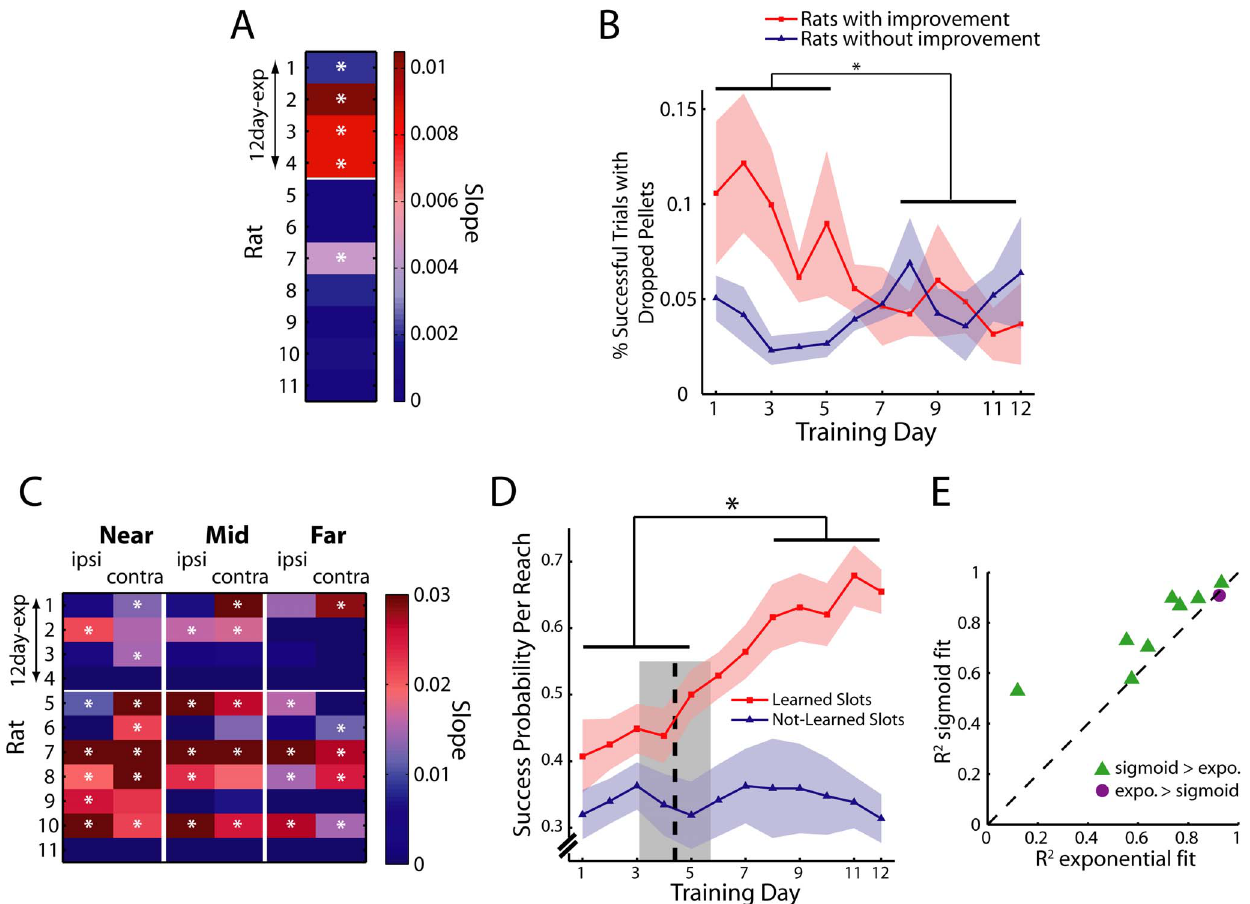
Figure 2. Improvement in task goal achievement exhibited a sigmoid time course. A, Eleven rats (rats 1–4 in 12-day-Reach group) were trained for 12 days to reach and grasp pellets from six different locations in the workspace, including slots ipsilateral (ipsi) and contralateral (contra) to the rat’s preferred side, at the Near, Mid, and Far levels (Fig. 1A), respectively. The first measure of motor learning we used indicates the quality of reaching by quantifying the percentage of successful trials in which the pellet was dropped either to the inside of the slit or to the box’s floor. Different rats showed different rates of improvement (blue, low rate of decrease; red, high rate) with 5 of the 11 rats showing a statistically significant decrease (*, Pearson’s correlation coefficient , 0, p , 0.05). The top four rows correspond to data from rats included in the microarray analysis. B, For the 5 rats showing across-day improvement in movement quality, there was a clear decrease in the percentage of successful trials with dropped pellets over time (red, mean 6 SE). The percentage values of the first five days were greater than those of the last five days for these rats (*, p , 0.05, ANOVA) but not for the other rats (blue). C, As a second measure of skill learning, we quantified the degree of task goal achievement across days. We examined whether there was across-day increase in the probability of successful retrieval per reach for each individual slot by linearly regressing the learning curve for each slot against time. Different rats exhibited performance improvement at different rates at different slots (blue, low improvement rate; red, high improvement rate) with different subsets of slots showing a significant increase in the success probability (*, Pearson’s correlation coefficient . 0, p , 0.05; ‘‘Learned’’ slot). The top four rows correspond to data from rats included in the microarray analysis. D, The probability of successful retrieval per reach was calculated over the slots showing significant improvement (Learned Slots; red, mean 6 SE) and the other remaining slots showing no improvement (Not-Learned Slots; blue), respectively. The learning curve for the Learned Slots exhibited a sigmoid time course with the success probability starting to increase at Day 4.4 6 1.3 (t 10%-max , black dotted line; mean 6 SE). For the Learned Slots, the probability values of the first 5 days were also significantly lower than those of the last 5 days (*, p , 0.05, ANOVA). E, The learning curve from the Learned Slots of every rat was regressed onto a sigmoid and an exponential function, respectively. When the regression R 2 values of the sigmoid fit were plotted against those of the exponential fit, all but one data point lay above the identify line (black dotted line) (green triangle, sigmoid . exponential; purple circle, exponential . sigmoid). doi:10.1371/journal.pone.0061496.g002 versus red; p . 0.05). Thus, the inter-group difference in movement five training days. For the movement quality measure of learning, quality before normalization reflects inter-individual variability in the raw percentage values (Day 1 to 5) for the 5-day-Reach rats were the initial performance on Day 1 rather than difference in the found to be higher than those for the 12-day-Reach values trend of improvement over time. For the task performance (F(1,39) = 7.8, p , 0.05). However, after normalizing the learning measure of motor learning, the success probability values (Day 1 to curves of both groups to their maximum, not only was there no 5) of the 5-day-Reach group (all slots) (Fig. 3B, green) were also not significant difference between the values of the two groups significantly different from those of the 12-day-Reach group for the (F = 0.67, p . 0.05), but the rate of decrease on the learning curve same time period (F(1,54) = 1.43, p . 0.05). from Day 1 to 5, as determined by the slope from linear regression, was also not different between the two groups (Fig. 3A, green